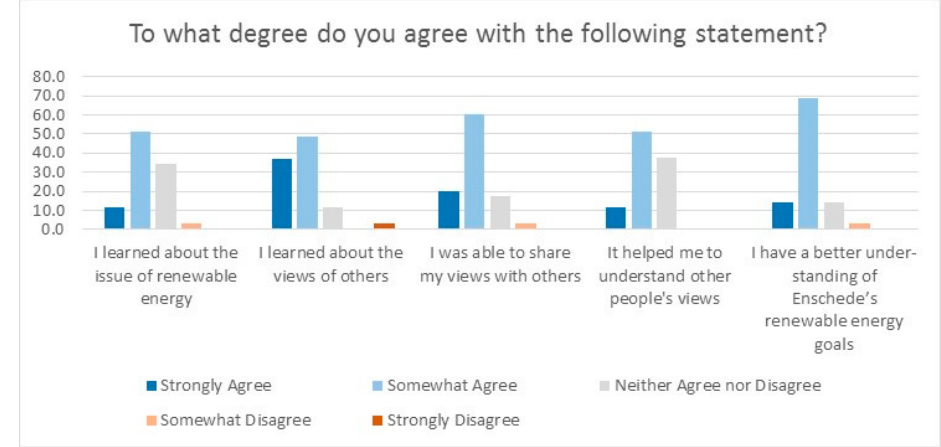
Figure 6. Lessons learnt by the participants.